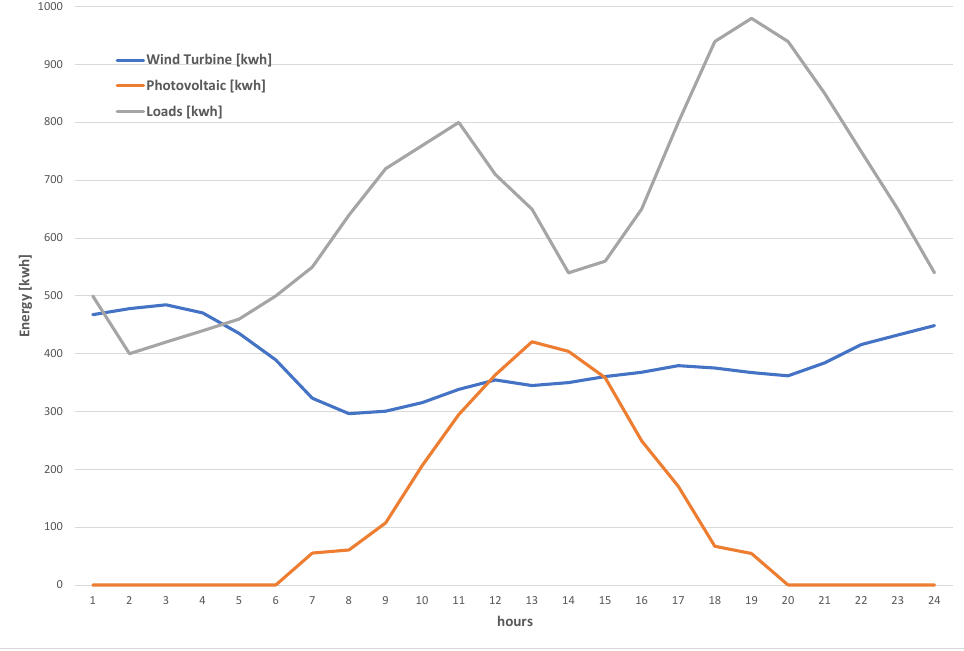
Figure 4. Mean E res ( t ) and L ( t ) daily